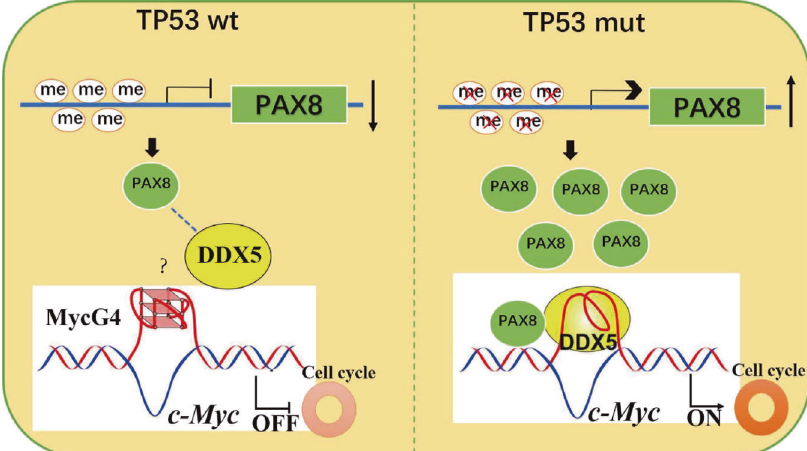
Fig. 7 Schematic diagram of the regulation of c-MYC by PAX8. In TP53 wild-type cells, a small amount of PAX8 is insuf fi cient to co-regulate the transcriptional level of c-MYC with DDX5, while in TP53-mutated cells, promoter hypomethylation leads to high expression of PAX8, which in turn cooperates with DDX5, possibly by unraveling the Myc4G structure leading to increased c-MYC expression and promotes cell cycle